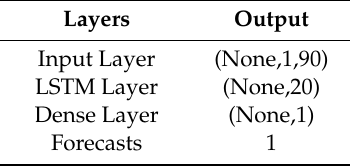
Table 2. LSTM architecture.